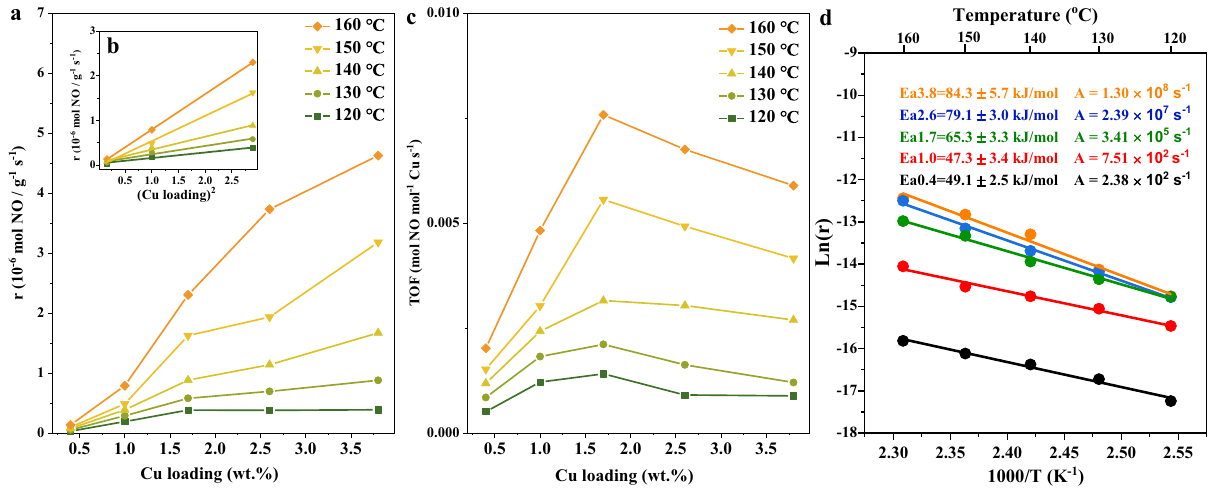
Fig. 1 | Kinetic analysis of standard SCR reaction. a SSCR reaction rates as a function of Cu loading. b SSCR reaction rates as a function of the square of Cu